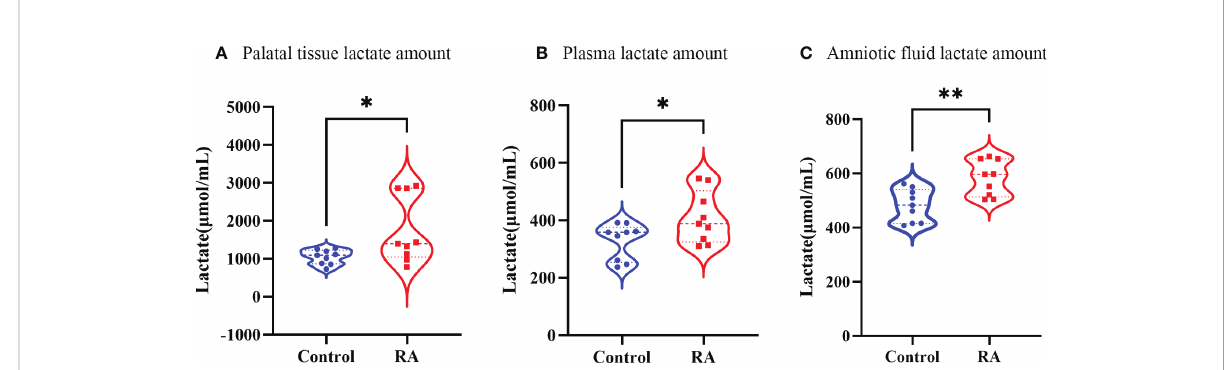
FIGURE 7 The lactate amount in RA and control group. (A) The lactate amount in palate tissue between RA and control groups (n=3). (B) The lactate amount in plasma between RA and control groups (n=3). (C) The lactate content in amniotic fl uid between RA and control groups (n=3). * p < 0.05, ** p < 0.01 compared with control